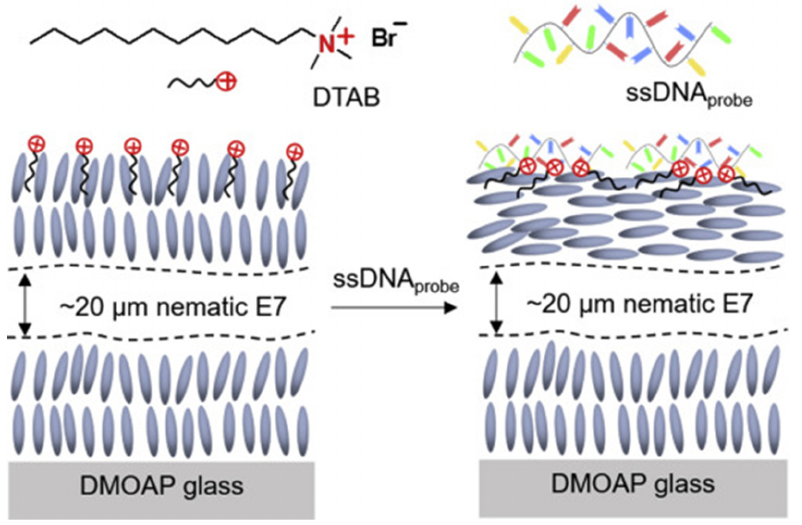
Figure 12. Schematic illustration of the optical response of the DTAB ‐ decorated LC film to the adsorption of the ssDNA probe. Reprinted/adapted with permission from Ref. [48]. 2022, Elsevier.